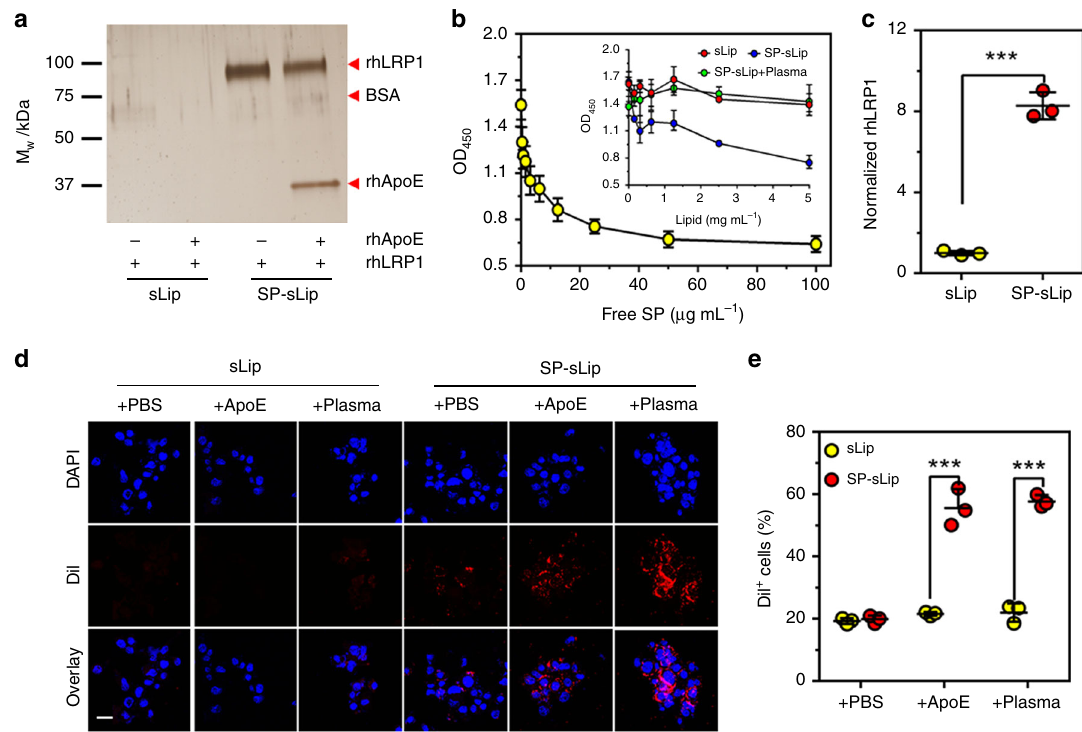
Fig. 3 Characterization of ApoE functions in protein corona. a sLip or SP-sLip (100 μ L, 10 mg mL − 1 lipid) were incubated with BSA (10 μ g mL − 1 ) with or without rhApoE (10 μ g mL − 1 ) for 1 h at 37 °C, then recombinant human LRP1 (rhLRP1) was added and incubated for another 1 h at 37 °C. Protein coronas were isolated by centrifugation at 14k RCF, separated by SDS-PAGE and stained with silver. b SP-PEG3400-DSPE dissolved in methanol (0.1 μ g per well) was coated in 96-well ELISA plate. After dry in room temperature, it was rinsed by cold PBS for three times. BSA (3%) was used to block for 2 h at room temperature. After thrice PBST rinses, anti-SP antibody (rabbit IgG, containing 0.1% BSA) was added and incubated for 1 h at 37 °C. Different concentrations of free SP (from 0 to 100 μ g mL − 1 ) or liposomes (sLip or SP-sLip, 0 – 5 mg mL − 1 lipid) with or without plasma were incubated for another 1 h at 37 °C. HRP-anti-rabbit IgG was applied to detect the primary antibody using TMB kit. c sLip or SP-sLip were incubated with plasma for 1 h at 37 °C, then I 125 radiolabeled rhLRP1 was added in the mixture for another 1 h incubation. The radioactivity of liposomes after three cycles centrifugation and rinses was counted for detecting the absorbed rhLRP1. d Microscopic observation of cellular uptake of DiI-loaded sLip (sLip/DiI) or SP-sLip (SP-sLip/DiI) by bEnd.3 cells. sLip/DiI or SP-sLip/DiI was preincubated with PBS, rhApoE (10 μ g mL − 1 ) or mouse plasma for 1 h at 37 °C, then incubated with bEnd.3 cells for 4 h at 37 °C. Cellular uptake was detected by confocal laser scanning microscopy. Scale bar = 20 μ m. e Quantitative analysis of DiI positive bEnd.3 cells by fl ow cytometry. Data are means ± SD ( n = 3), and analyzed with GraphPad Prism 6.0. *** p < 0.001 by student ’ s t